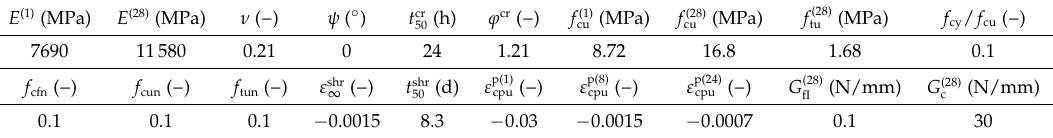
Table 3. Material parameters for the Schädlich